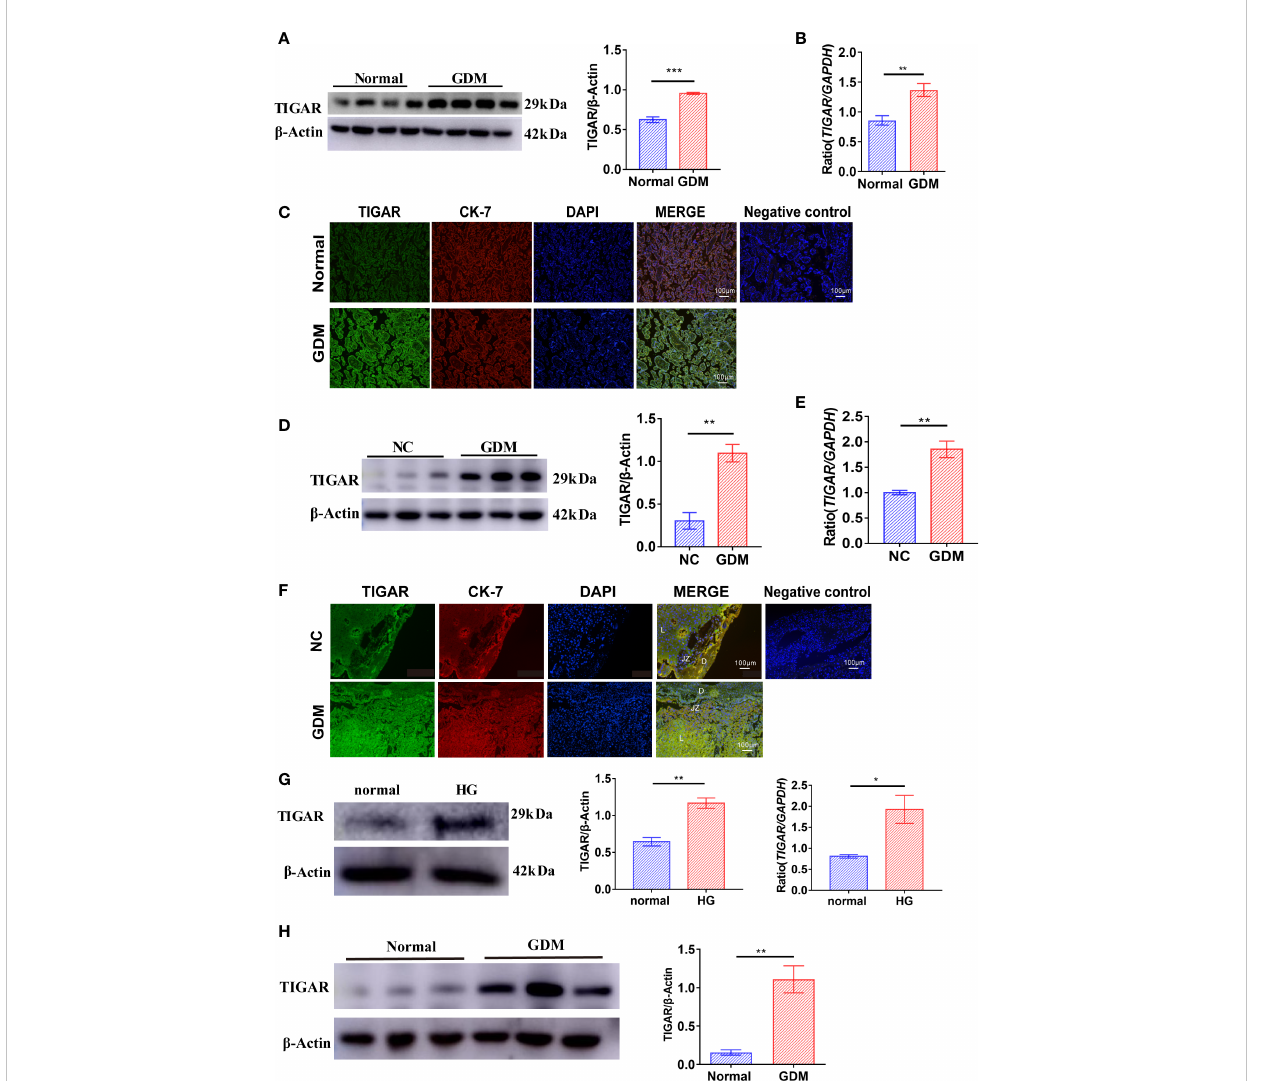
FIGURE 1 TIGAR levels were upregulated in the placenta of patients and mice with GDM and HTR-8 cells cultured with high glucose. (A) Immunoblotting for TIGAR in placental lysates from patients with GDM (n=4) or Normal patients (n=4). (B) q-PCR analysis of TIGAR in placental tissues from patients with GDM (n=6) or Normal patients (n=6). (C) Immunostaining for TIGAR on the free villous (FV) of placental sections from patients with GDM (n=4) or Normal patients (n=4). Negative control for the Immuno fl uorescent staining of TIGAR expression was on the right. Scale bar=100 m m. (D) Immunoblotting for TIGAR in placental lysates from GDM mice (n=3) or NC (n=3). (E) q-PCR analysis of TIGAR in placental tissues of GDM mice (n=6) or NC (n=6). (F) Immunostaining for TIGAR on the labyrinth zone (Lz) of placental sections from GDM mice (n=4) or NC (n=4) and we illustrated the structure of placenta, as Decideua (De), labyrinth zone (Lz), junctional zone (Jz) in the images, negative control for the Immuno fl uorescent staining of TIGAR expression was on the right. Scale bar=100 m m. Immunoblotting (G) and q-PCR analysis (H) for TIGAR in HTR-8 which cultured in 5.5mM normal glucose and 30mM high glucose (HG) (n=3). *p < 0.05, **p < 0.01, ***p < 0.001 versus the indicated group. TIGAR, TP53 induced glycolysis regulatory